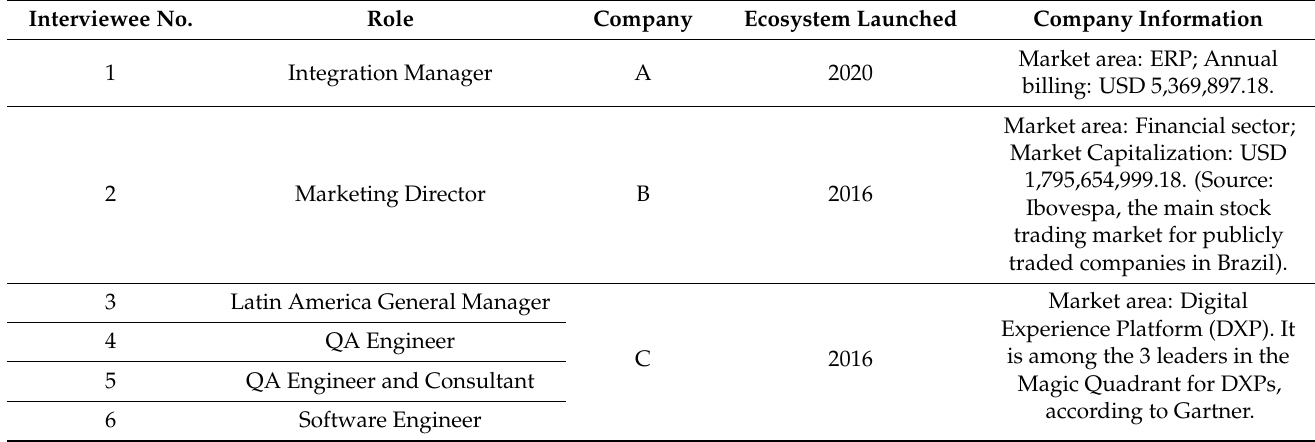
Table 2. Profiles of the